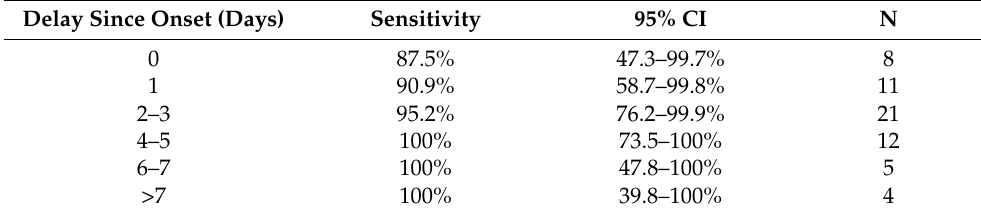
Table 3. Sensitivity of Visby device by the delay since symptom